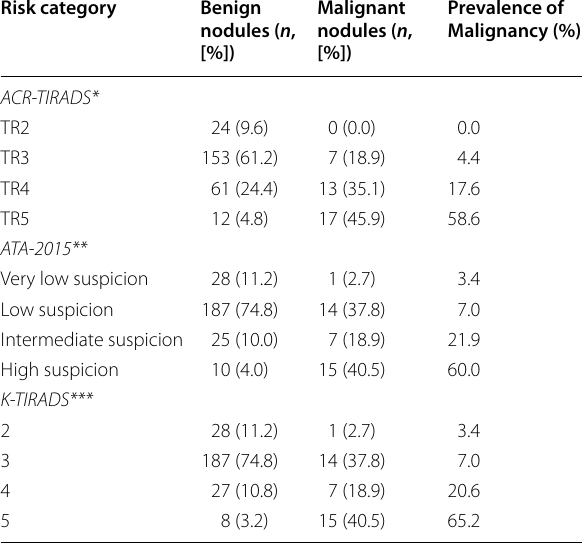
*American College of Radiology—Thyroid imaging reporting and data system **American Thyroid Association ***Korean thyroid imaging reporting and data